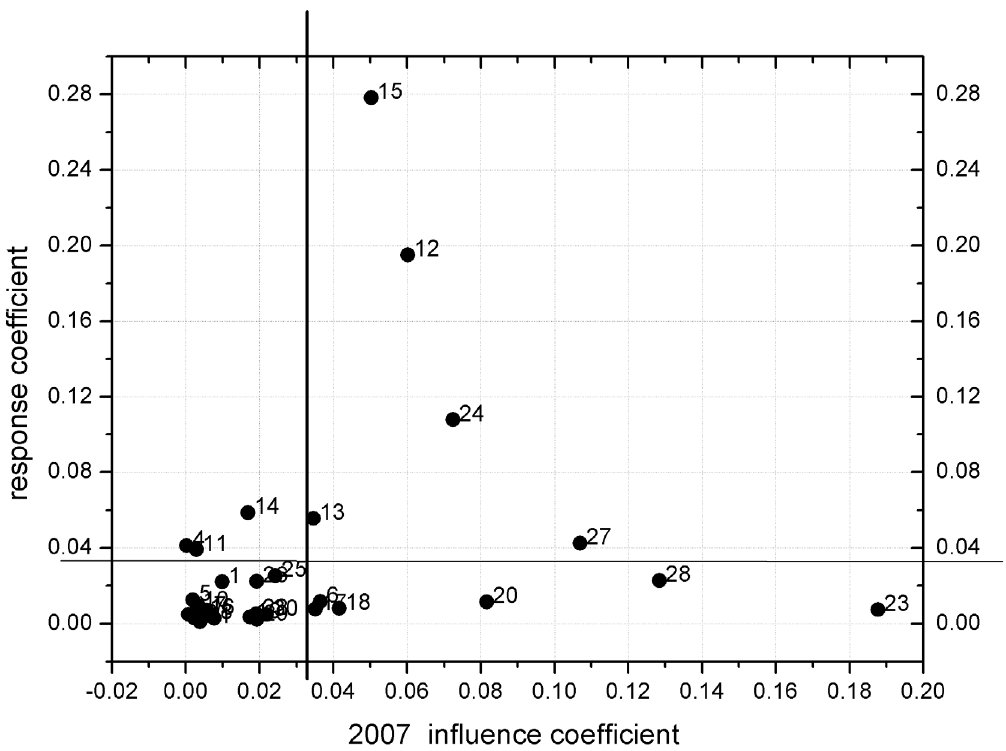
Figure 6. Planar graph of RC and IC of the 30 sectors in 2007 (see Table 2 for sector code definitions).